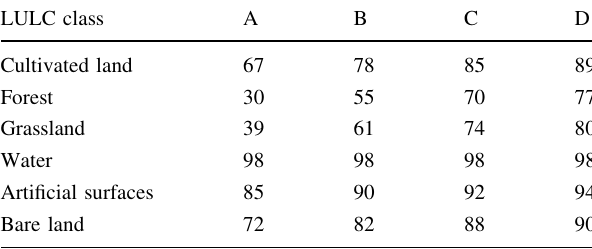
Table 2 Curve numbers for hydrologic soil groups A, B, C, and D in the Xiang River Basin. Source Cronshey (1986) and Yuan (2003) LULC